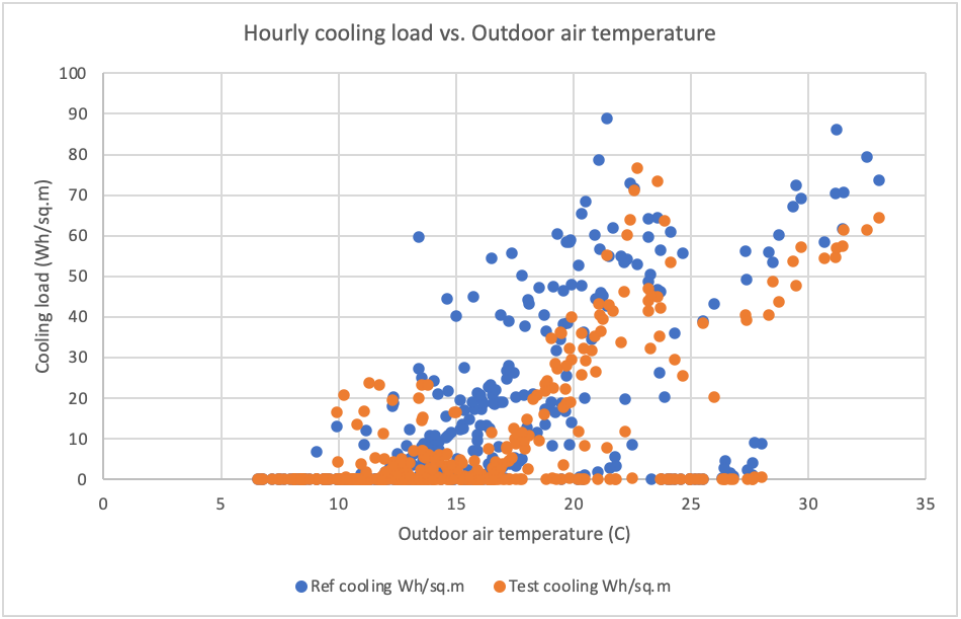
Figure 9. Cooling load vs. outdoor air temperature for Core-S for test and reference cells.